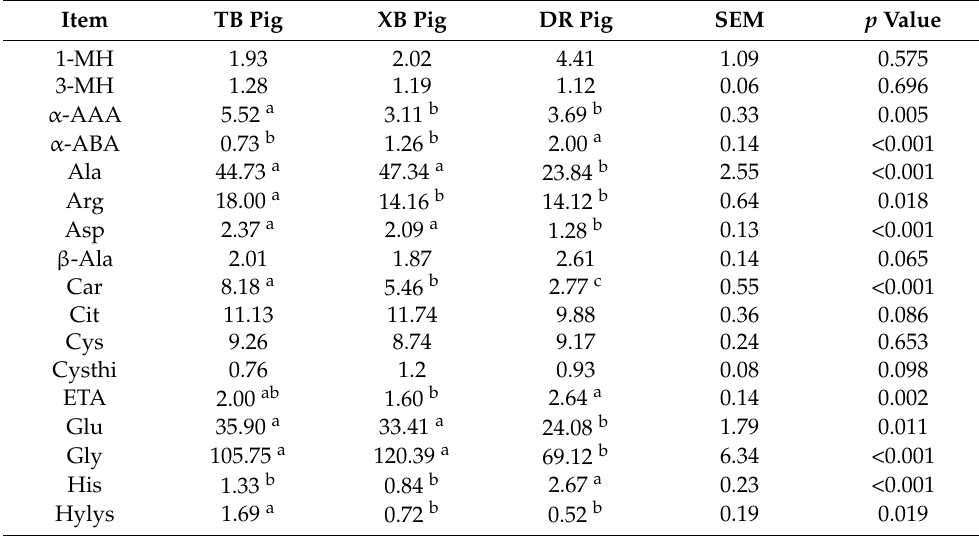
Table 5. Plasma free amino acids composition of three pig breeds at 80 days of age ( µ g/mL). Item TB